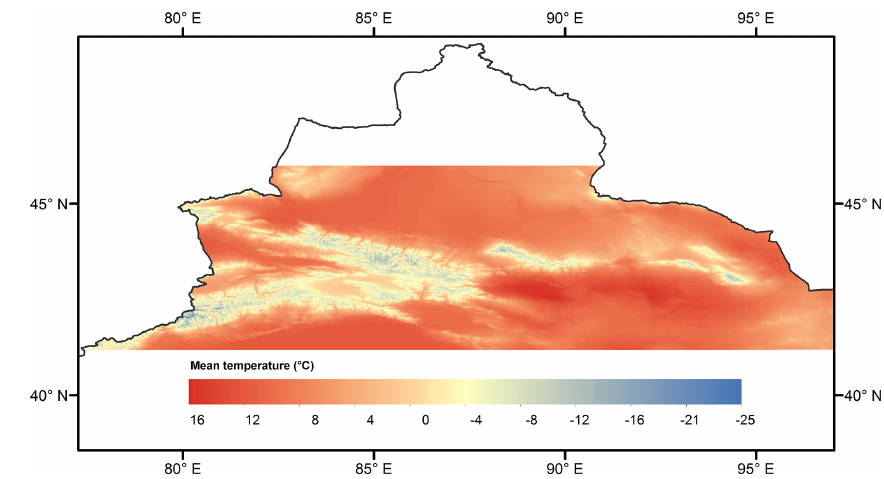
Figure 8. Mean temperature of the entire CTM based on the high-resolution data set.